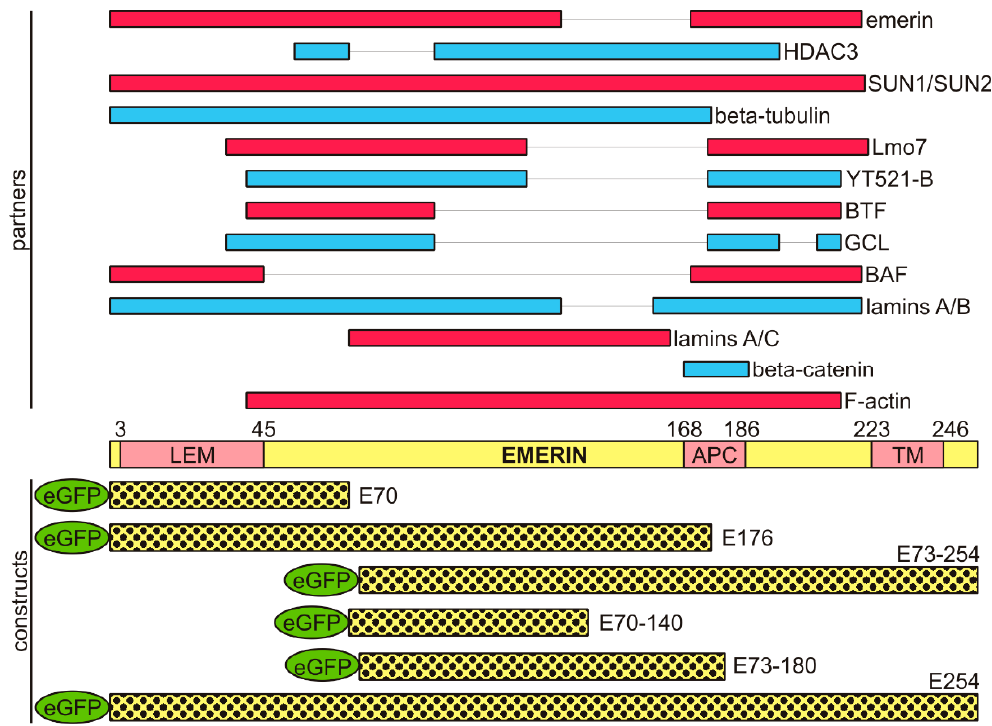
Figure 1. Functional domains identified in emerin, emerin domains identified as necessary for interaction with other nuclear proteins, and constructs used in this study. Emerin contains a LEM domain [32,33] on its very N-terminus, followed by a so-called LEM-like domain located within the functional lamin-binding domain. The Adenomatous Polyposis Coli (APC)-like domain, responsible for interaction with β -catenin, localizes to fragment 168–186 aa residues, and the transmembrane domain localizes to 223–246 aa residues. Upper: emerin interactions and mapped emerin domains necessary for the interactions. Lower: the set of genetic constructs prepared in our laboratory and used for the study. LEM—LAP2 Emerin MAN1 domain; APC—domain necessary for interaction with β -catenin and Wnt signaling; TM—transmembrane domain; EGFP—the position of the EGFP protein fused to emerin proteins. Numbering represents amino acid residue numbers present in a particular construct. E70—deletion mutant containing amino acid residues from 1 to 70; E70–140—a construct containing amino acid residues from 70 to 140. The rest of the mutants are designated following the same pattern.